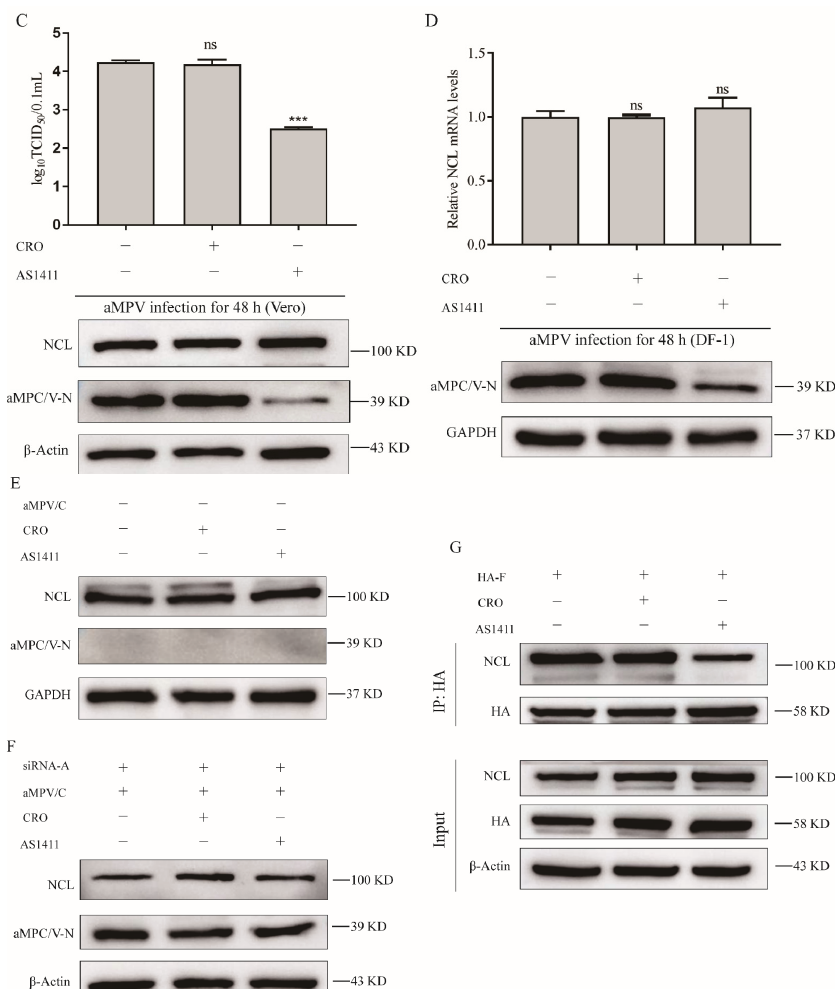
Figure 5. NCL binding aptamer AS1411 inhibits viral replication by disrupting the interaction between NCL and aMPV/C F. After 72 h of treatment with FAM − AS1411 in DF − 1 cells and Vero cells, the FAM − signal and the toxicity of AS1411 were tested by confocal microscopy ( A ) and the CCK − 8 assay ( B ). Vero cells and DF − 1 cells treated with AS1411 or CRO for 24 h were infected with aMPV/C, and the cells and supernatants were collected at 48 h after infection. The viral titers ( C ) and expression of aMPV/C N and NCL ( D ) were assessed using western blot, qRT − PCR, and TCID 50 assay. ( E ) After treatment of cells with AS1411 or CRO for 72 h, western blot was utilized to detect the expression of NCL in Vero cells. ( F ) Vero cells were treated with NCL − siRNA for 24 h and then infected aMPV/C in the presence of AS1411 or CRO. Western blot analysis was used to detect the expression of aMPV/C N and NCL. ( G ) Vero cells were transfected with pCMV − HA − F for 36 h in the presence of AS1411 or CRO. The cell lysates were extracted, and an IP assay was performed using HA mAb, followed by immunoblotting with mAbs against HA and NCL. β − actin or GAPDH was used as internal control. *** p < 0.05 were considered statistically significant; ns, not